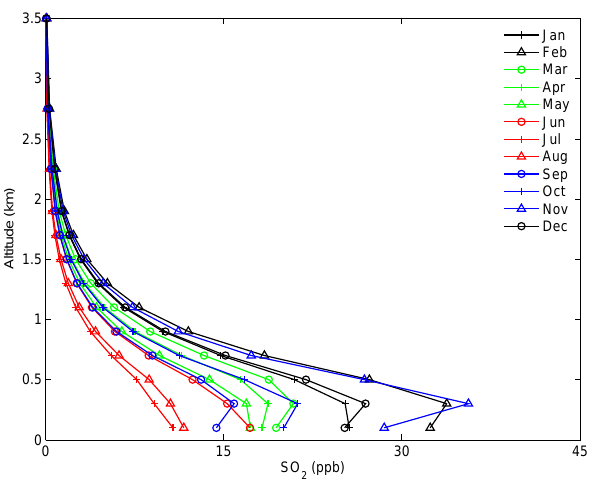
Figure 7. Seasonally averaged DFS diurnal cycles corresponding to the SO 2 profile